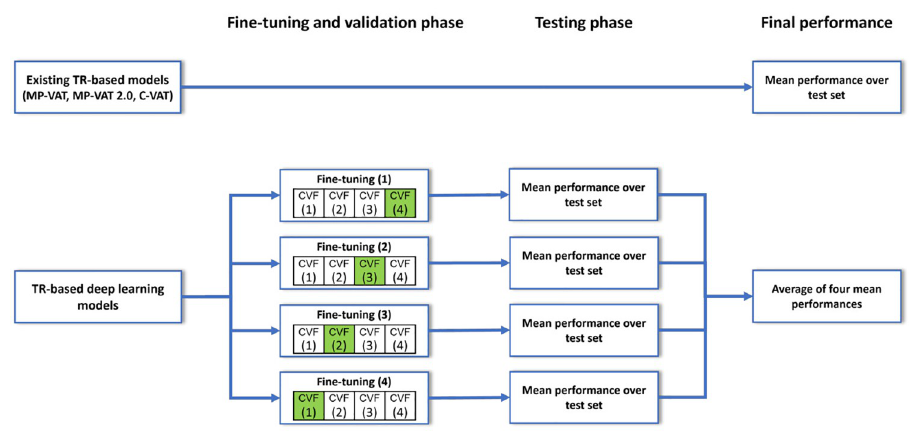
Fig 5. Dataset segregation. Dataset segregation for fine-tuning, validation, and testing of the already existing TR- based models and the TR-based deep learning models. Green-colored boxes refer to the fold used for validation, while white-colored boxes denote the folds used for fine-tuning.